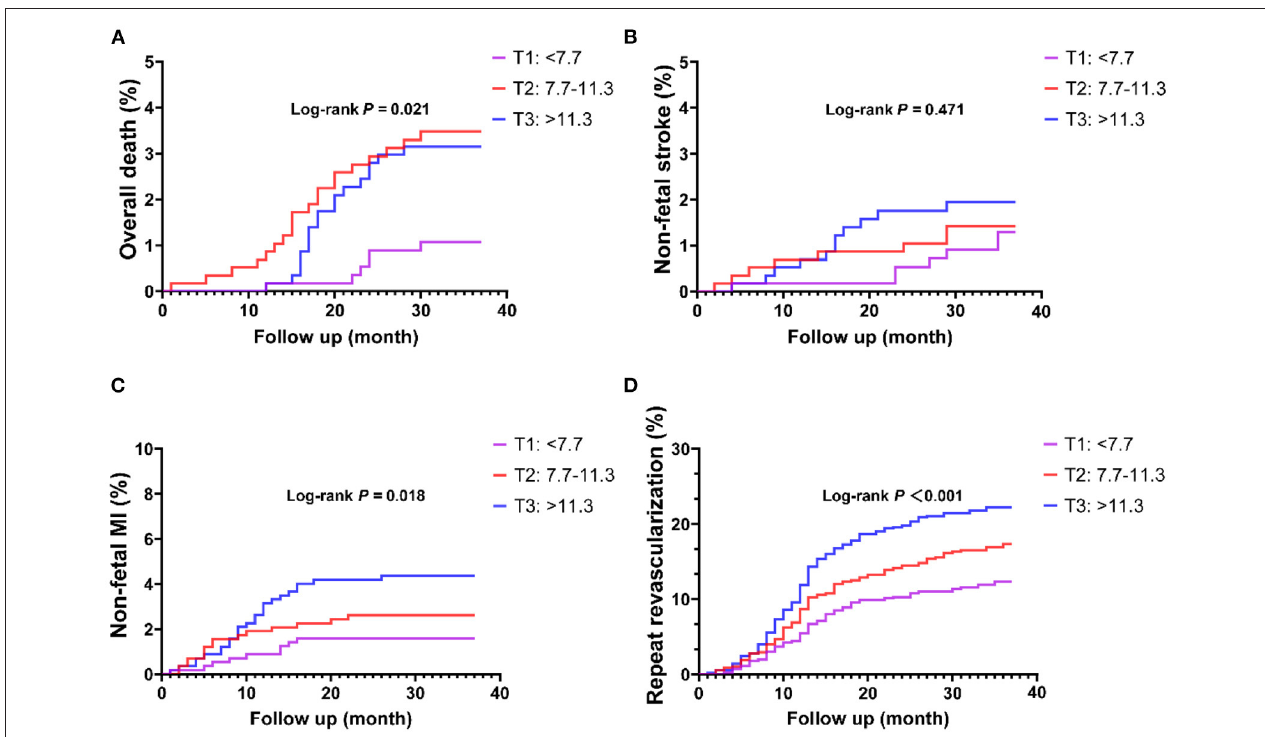
FIGURE 3 | Kaplan-Meier curves of each component of the primary endpoint stratified by the MHR tertiles. (A) Overall death; (B) non-fatal stroke; (C) non-fatal MI; (D) repeat revascularization. MI, myocardial infarction.